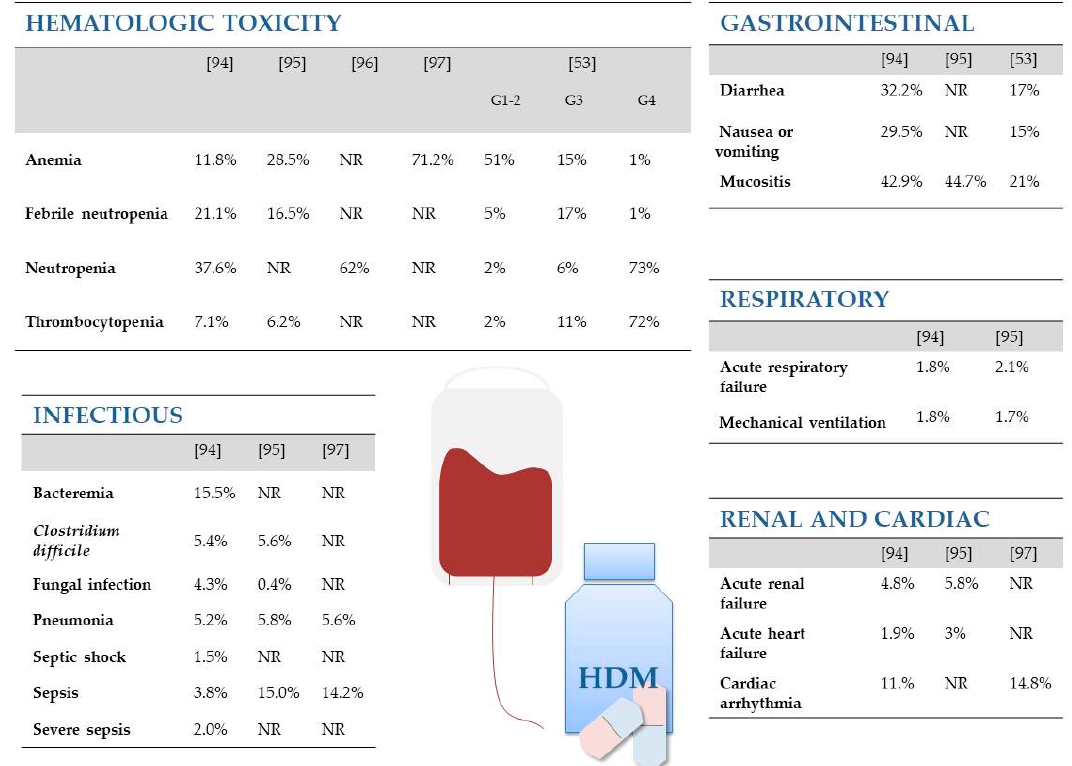
Figure 1. Side effects of HDM-ASCT therapy include: hematologic toxicity, infection, gastrointestinal complaints, pulmonary disease, acute renal failure, and cardiac arrhythmias. Figure based on [53,94–97]. G-grade (adverse events grades 1–2 occurring in at least 10% of patients and adverse events grades 3–4 in all patients [53]); NR, not reported.